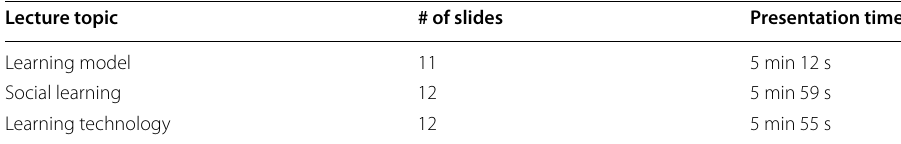
Table 2 Details of video lectures